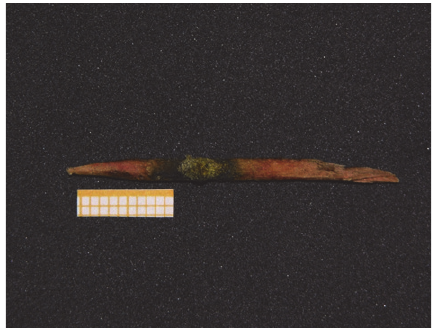
Figure 4: Extracted